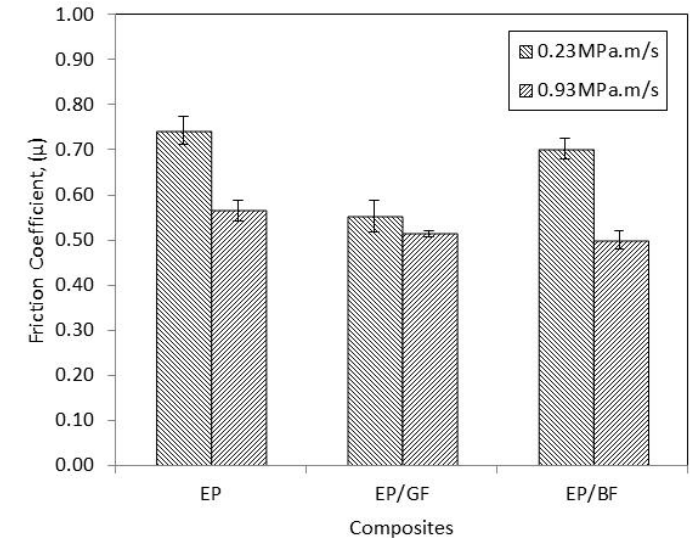
Figure 4. ( a ) Specific wear rate and ( b ) friction coefficient of pure epoxy and its composites under low and high PV factor of unidirectional sliding.